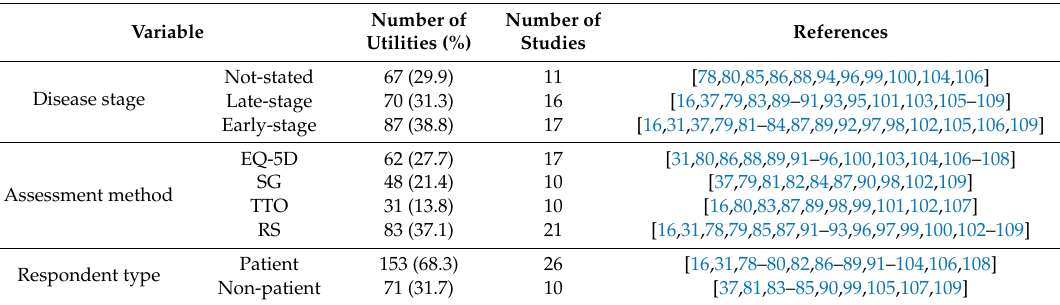
Table 2. Characteristics of the utility weights by disease stage, assessment method, respondent type, survey origin, scale bounds, and administration